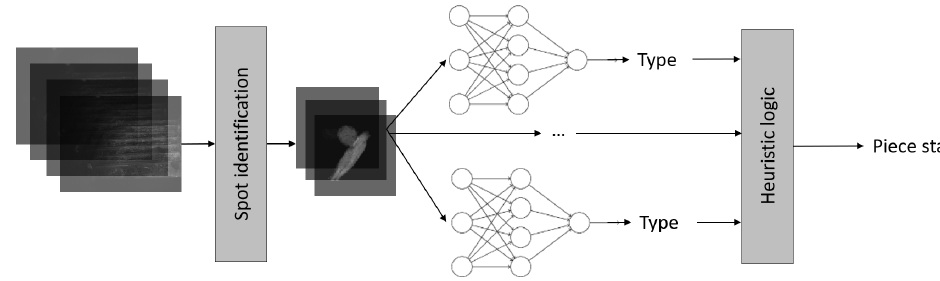
Figure 3. First (basic) system architecture: each spot box is analysed by a neural network.